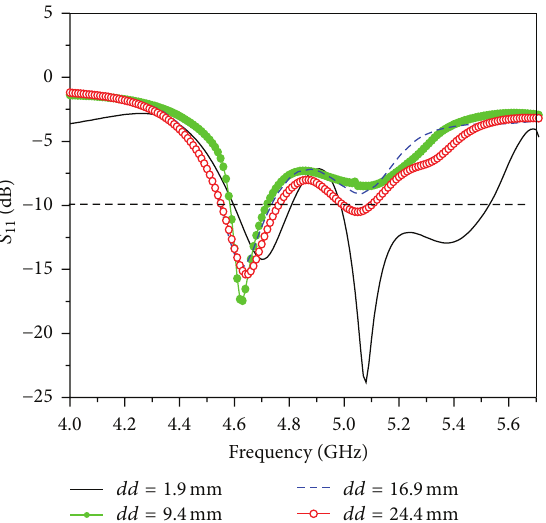
Figure 10: Simulated 𝑆 11 as a function of 𝑑𝑑 .